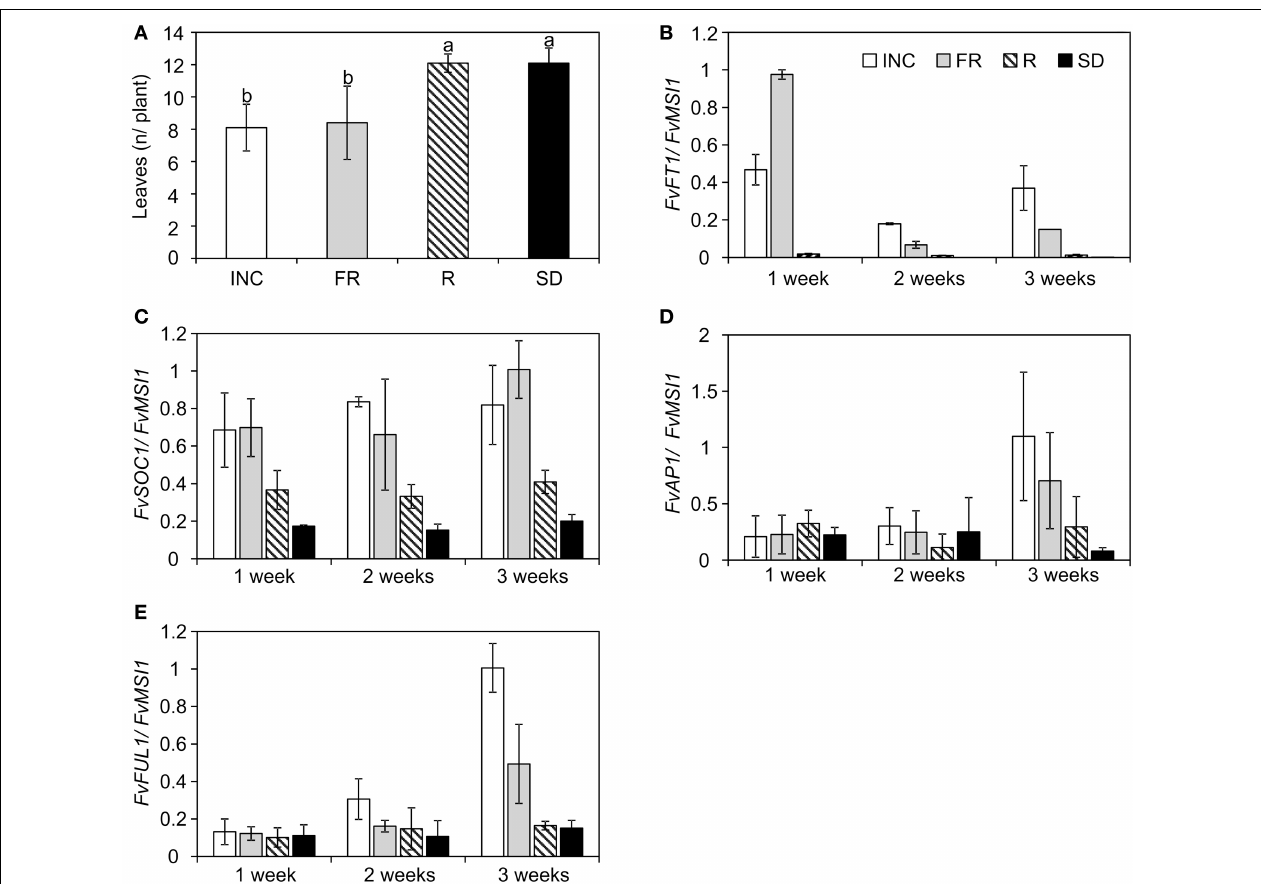
FIGURE 1 | Flowering time and the expression of flowering time genes under the end-of-day light quality treatments in the perpetual flowering F. vesca accession Hawaii-4 (H4). (A) Flowering time of the seedlings of H4 indicated as the number of leaves in the primary leaf rosette before the terminal inflorescence ( n = 8–11). Flowering results were subjected to One-Way ANOVA ( t -test), p < 0 . 001 for the treatment. Different lower-case letters indicate significant differences between the treatments according to Tukey’s pairwise test, α = 0 . 05. (B) The expression of FvFT1 in the leaves of